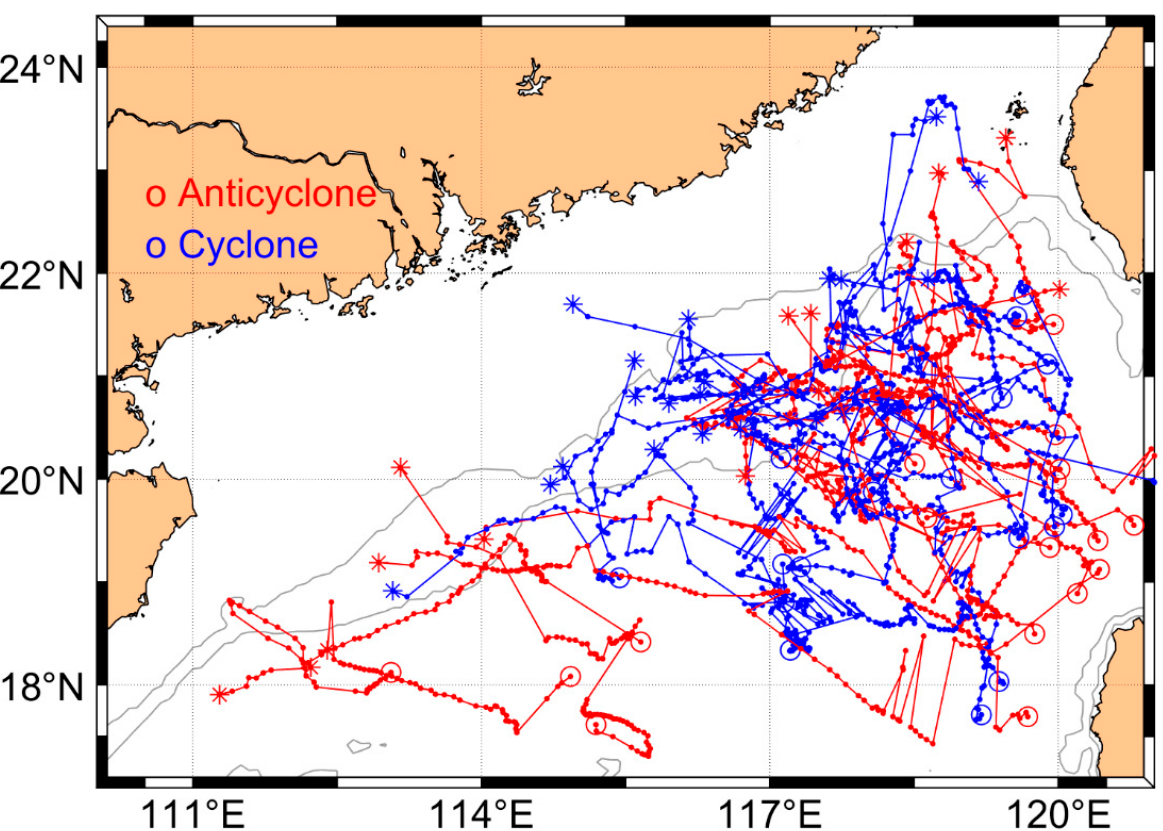
Figure 6. The pathways of the intrusion-of-continental-shelf mesoscale eddies. The red curves with points are anticyclonic eddies. The blue curves with points are cyclonic eddies. The circles indicate generation and the asterisks indicate corruption.